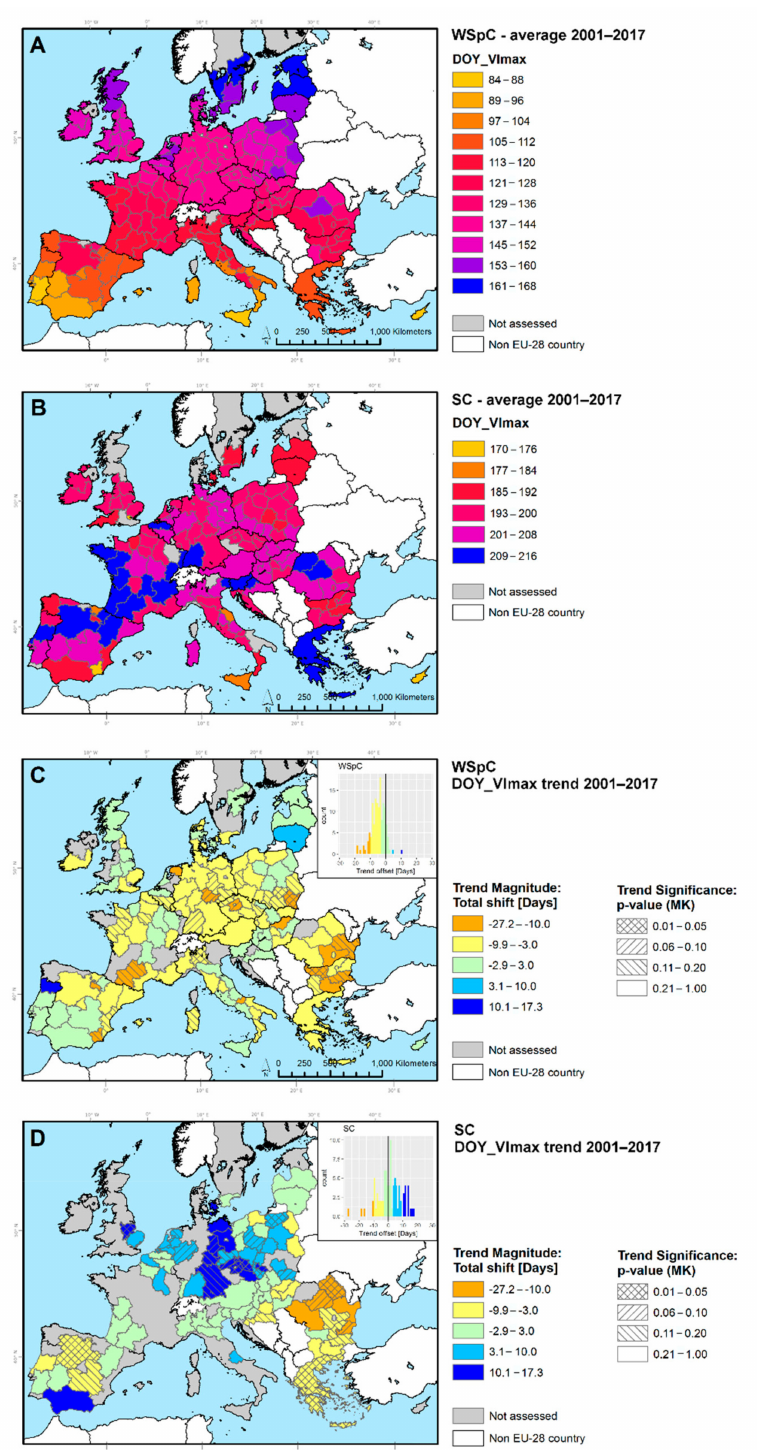
Figure 9. Average DOY_VImax values of the years 2001–2017 for WSpCs ( A ) and SCs ( B ), averaged by region. Magnitude and significance of DOY_VImax trends from 2001–2017 for WSpCs ( C ) and SCs ( D ), averaged per